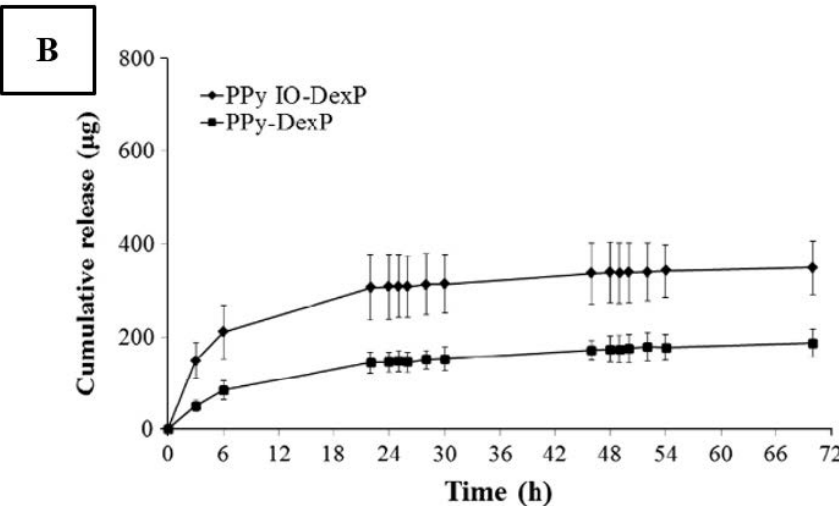
Figure 9. ( A ) Drug release profiles for polypyrrole inverse-opal dexamethasone phosphate films and conventional nonporous polypyrrole dexamethasone phosphate films. Following 24 h of a passive release, 1 h periods of electrical stimulation were applied (arrowed time points) at 24 and 48 h ( n = 3, mean ± standard error) and ( B ) control drug release profiles, without electrical stimulation, for PPy IO–DexP and conventional PPy–DexP films ( n = 3, mean ± standard error). Using electro-responsive macroporous polypyrrole scaffolds for triggered dexamethasone delivery. Reprinted with permission from ref. [128]. Copyright 2015 Elsevier.